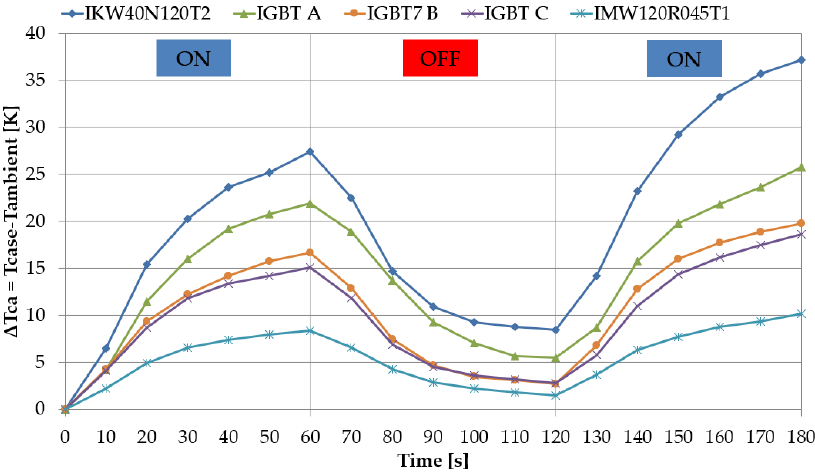
Figure 2. Thermal behavior of the power semiconductors in motor drive application.